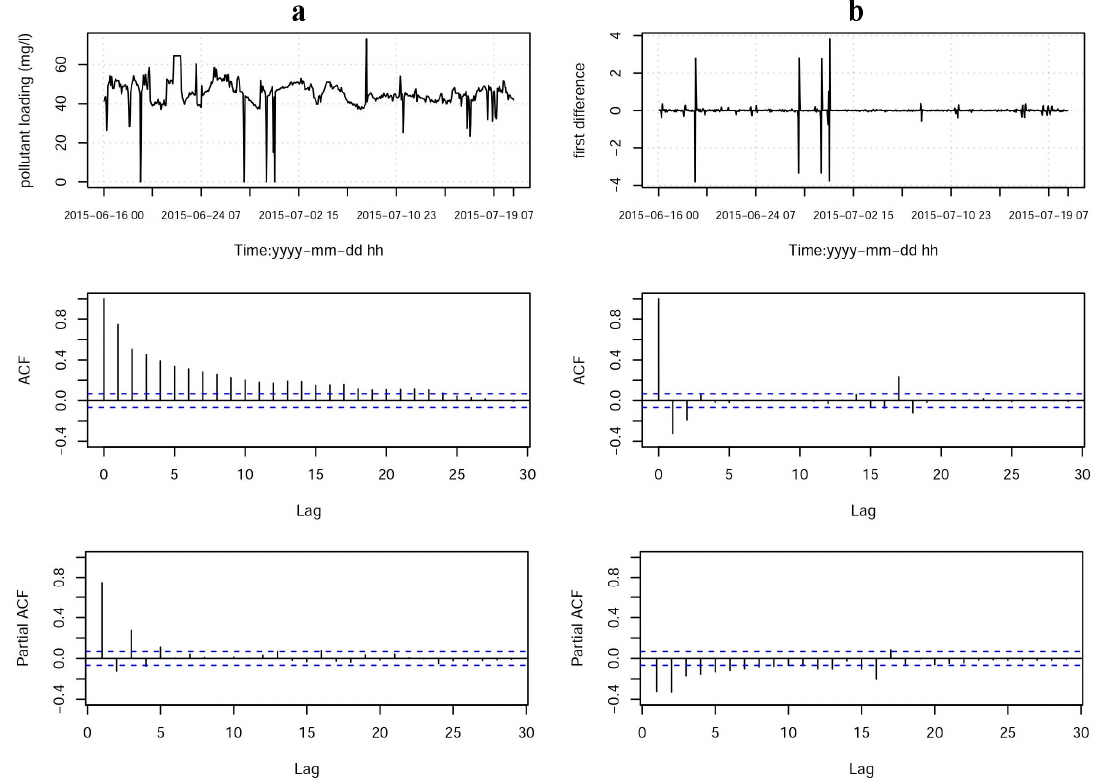
Figure 5. Series plot, ACFs and PACFs: ( a ) original sample data; ( b ) differenced series. The autocorrelations are significant for a large number of lags, but perhaps those at lag-2 and above are merely due to the propagation of the autocorrelation at lag-1. This can be confirmed by the PACF plot. Note that the PACF plot of original data has another significant spike at lag-3 in addition to lag-1, meaning that the higher-order autocorrelations cannot be easily explained by the lag-1 autocorrelation. Differencing should therefore be performed for further analysis.